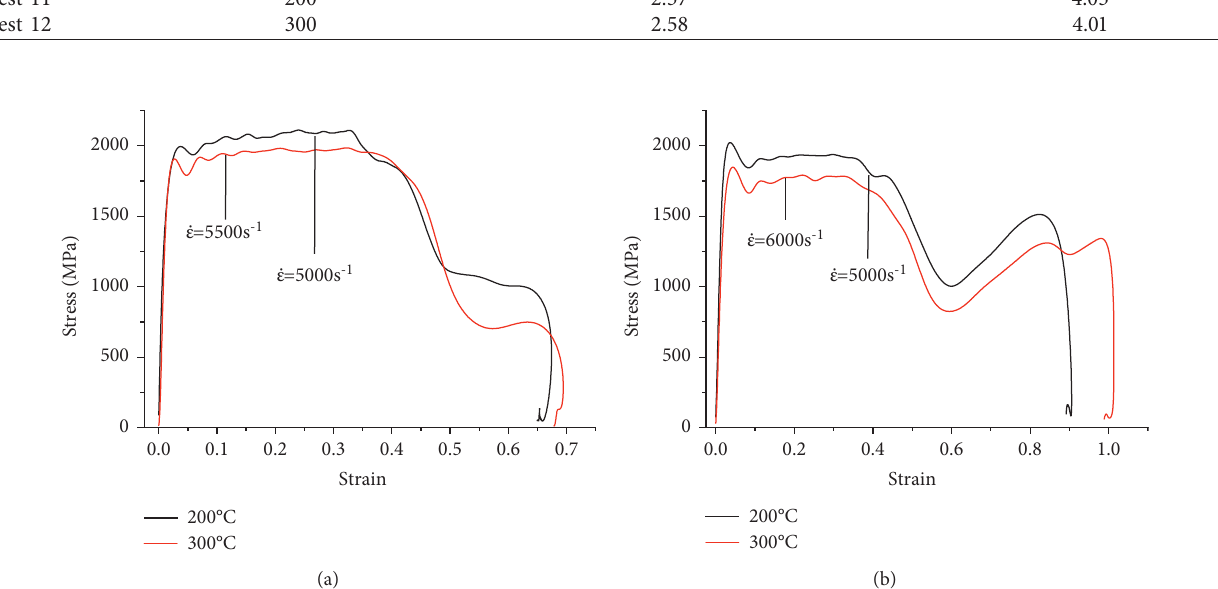
Figure 13: Dynamic compression stress-strain curve at varying temperature. (a) QP980 steel RSW; (b) TRIP800 steel